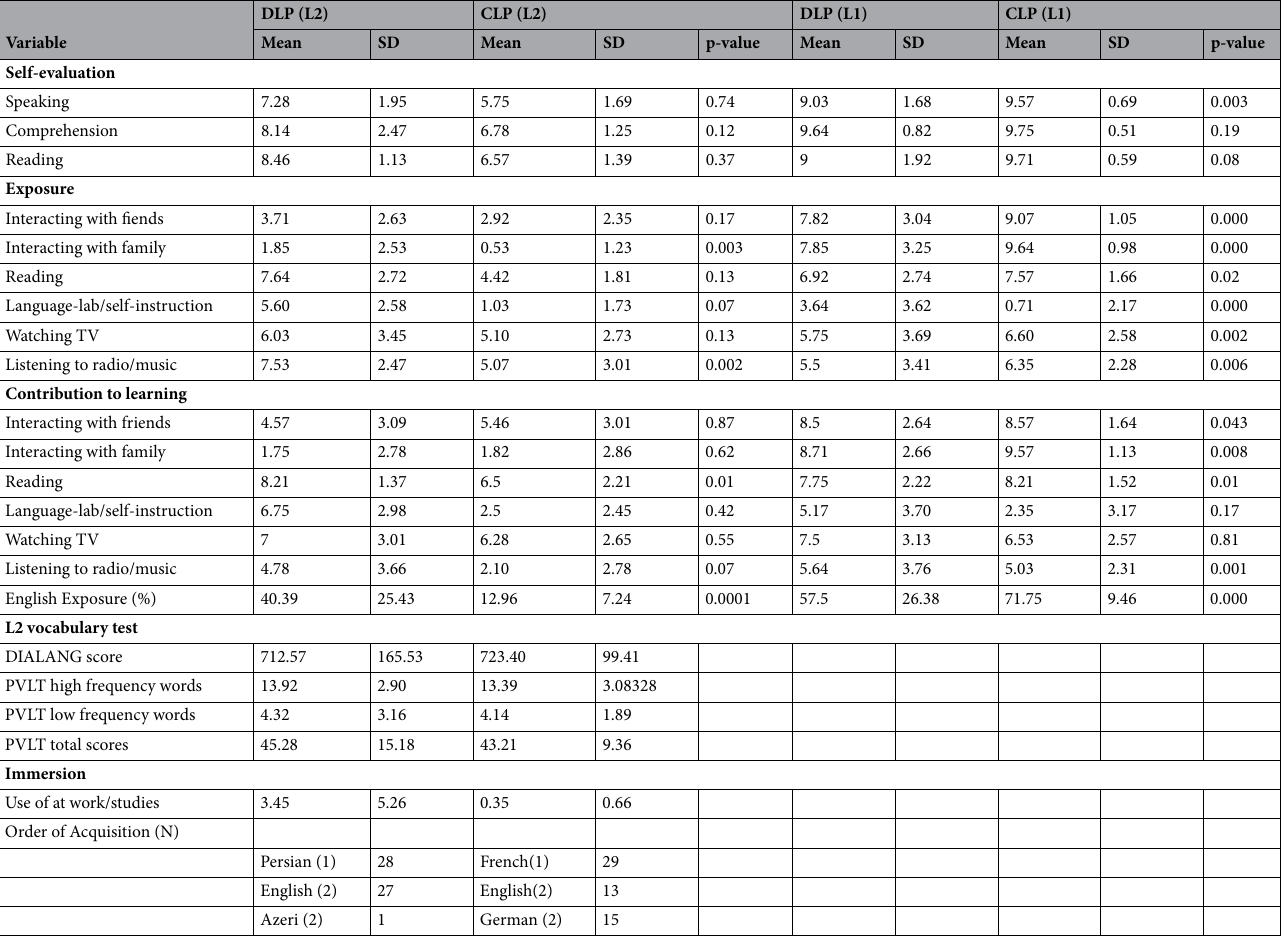
Table 1. First and second language proficiency, usage and